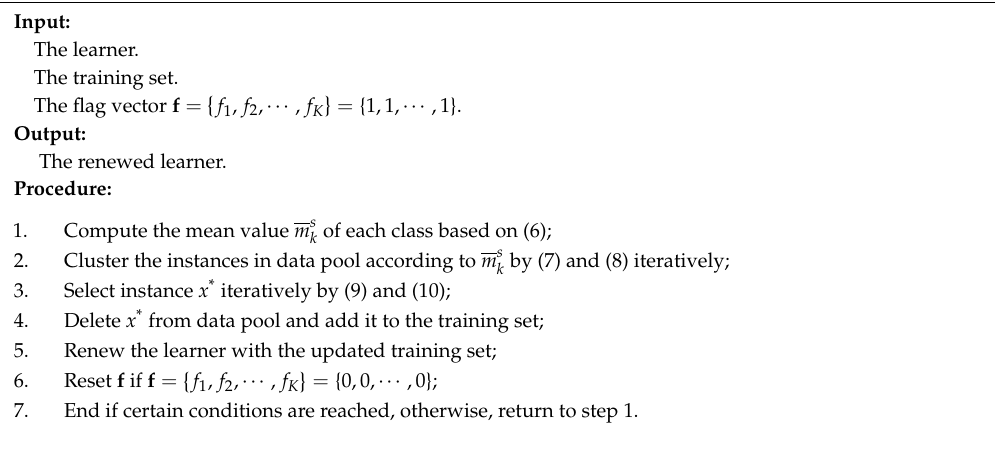
Algorithm 1. Algorithm of active learning on dynamic